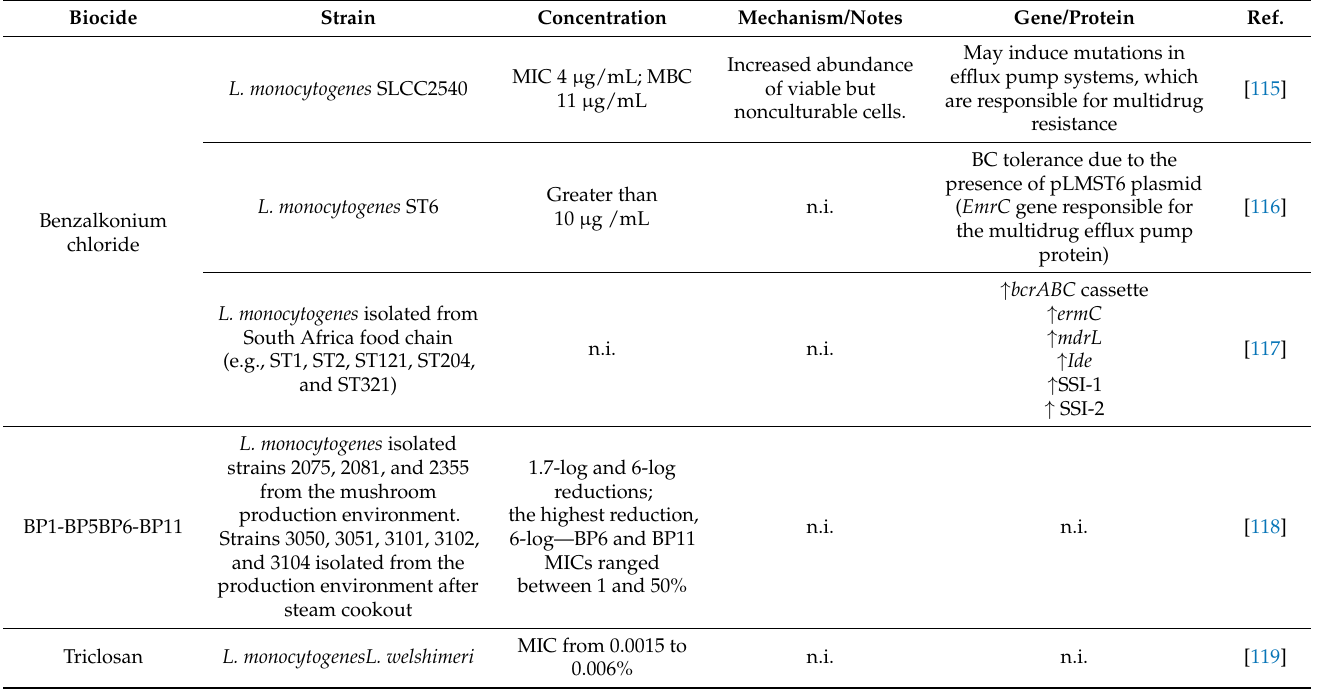
Table 5. Biocides and their impact on Listeria